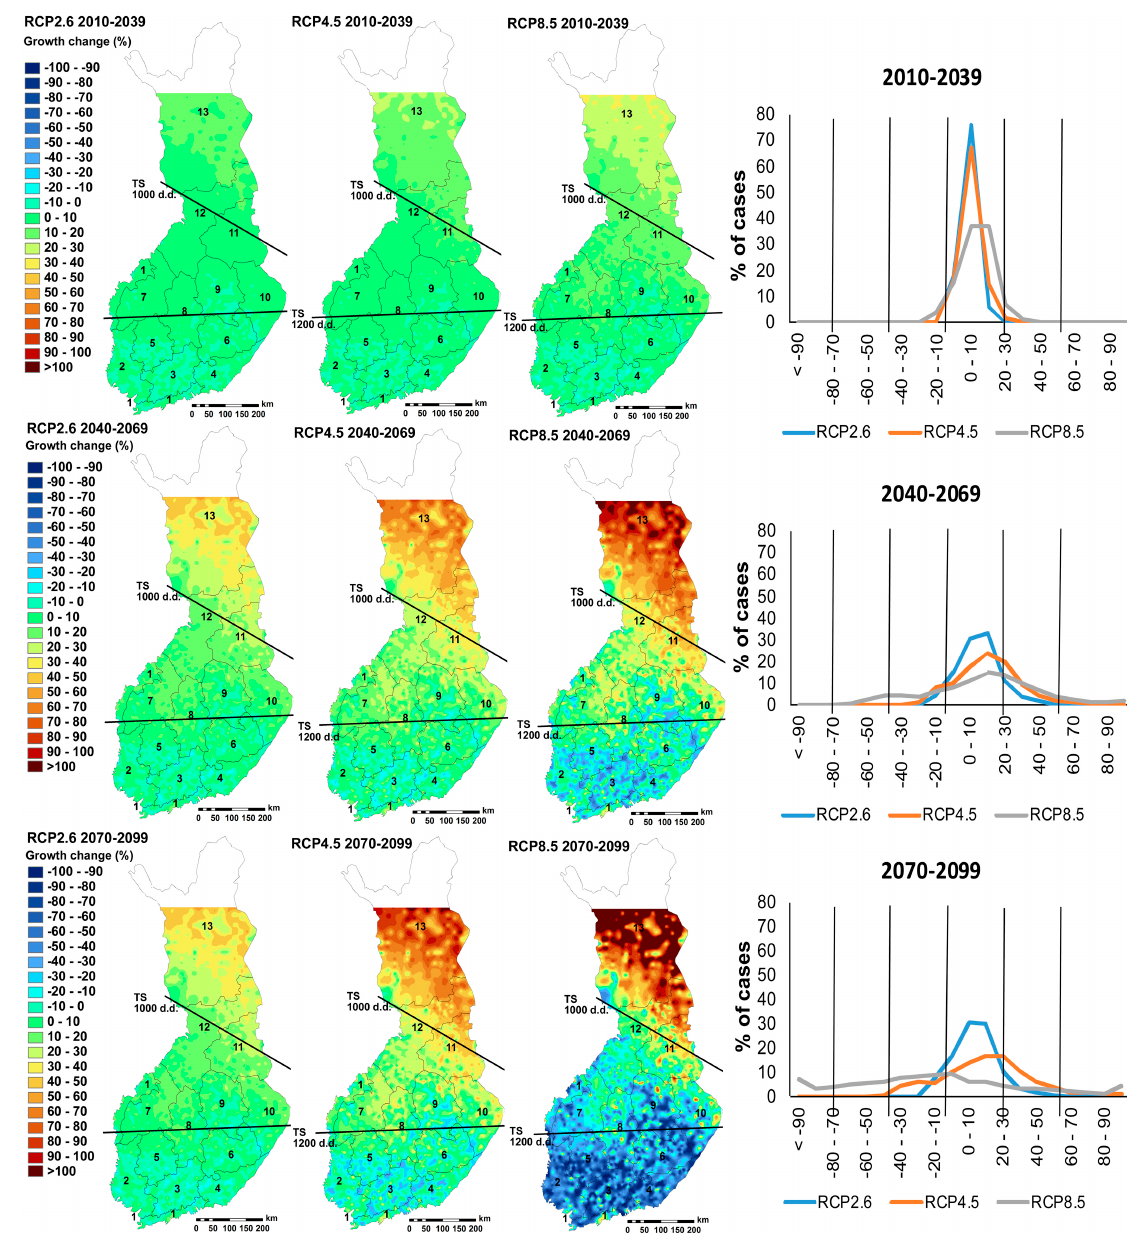
Figure 6. Left : Spatial distribution of the mean increase in diameter growth over all tree species on upland forest sites for different 30-year calculation periods (2010–2039, 2040–2069, and 2070–2099) under the minor (RCP2.6), moderate (RCP4.5), and severe (RCP8.5) climate change scenarios. The numbers in the figures indicate the old administrative forest center regions. Right : Percentage distribution of changes in growth responses in relation to total number of cases, for different 30-year periods and RCP scenarios, across the whole country. If drained peatland sites were included in calculations, positive responses of growth would have been slightly higher and the negative ones lower (see Table 5).